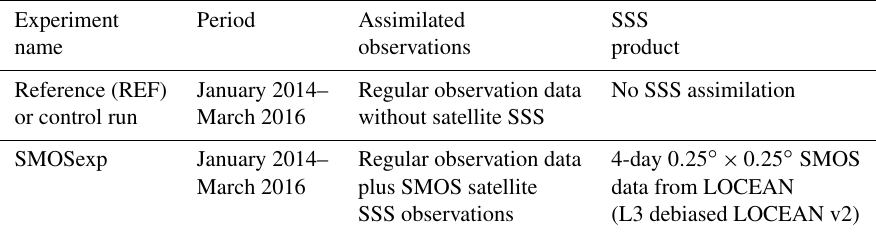
Table 2. Experiment